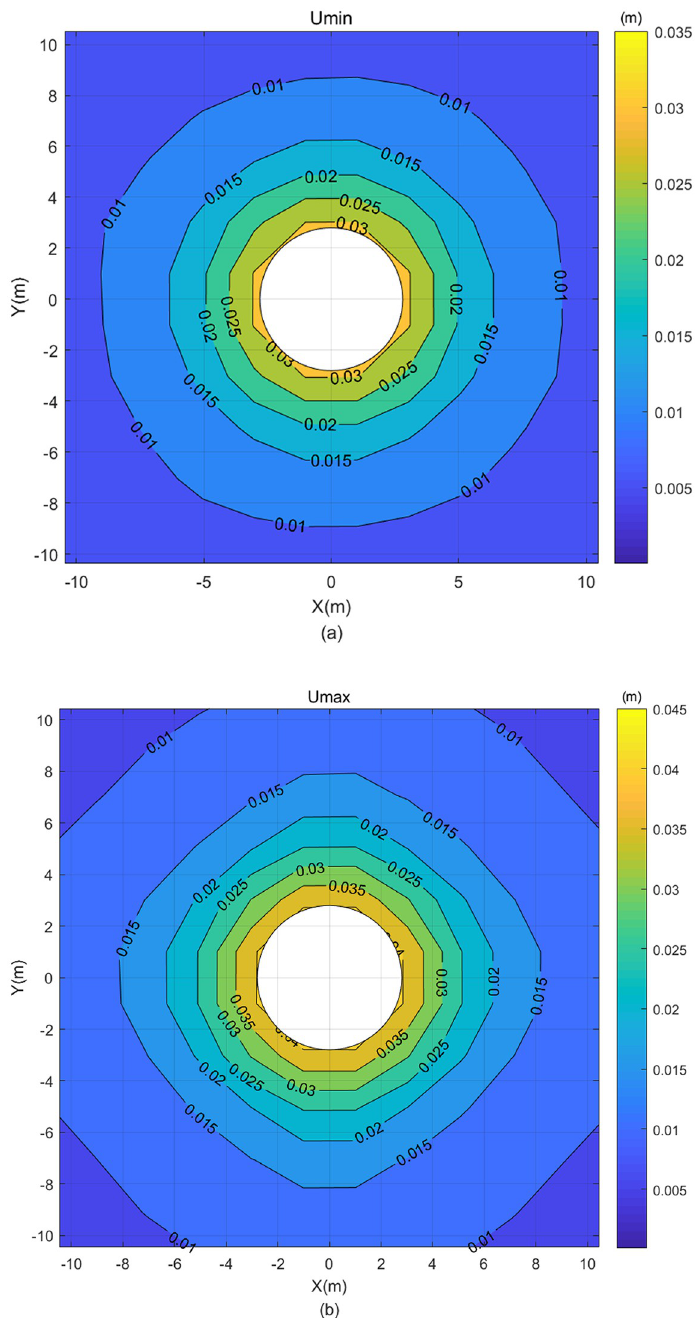
Fig 11. Displacement contour map calculated by Eq (32) without rearranging the grey matrix—(a) Umin and (b) Umax. analyzed the grey properties, grey parameters and grey variables of rock and soil system, established the basic equilibrium equations and the FEM equations with grey variables, and used the operation properties of grey number to solve the FEM equations with grey variables.